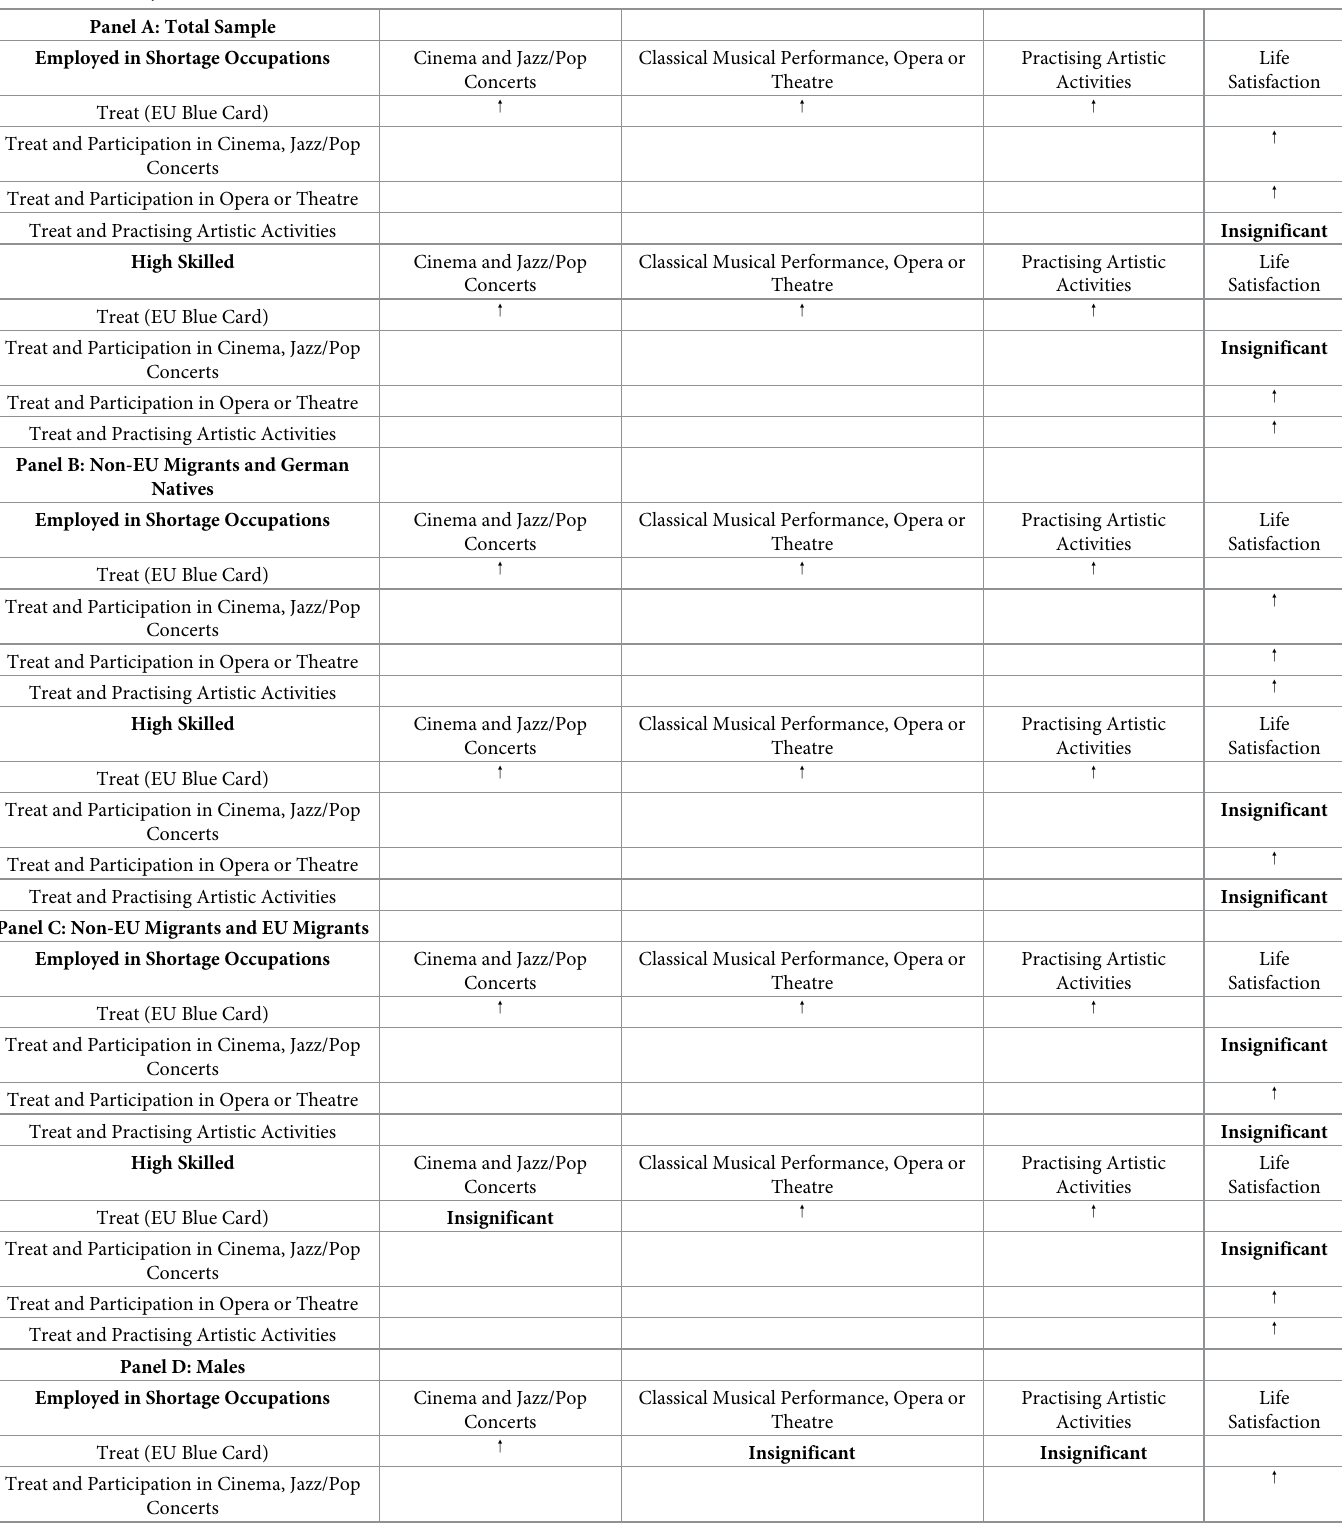
Table 13. Summary of the FRDD results. Panel A: Total